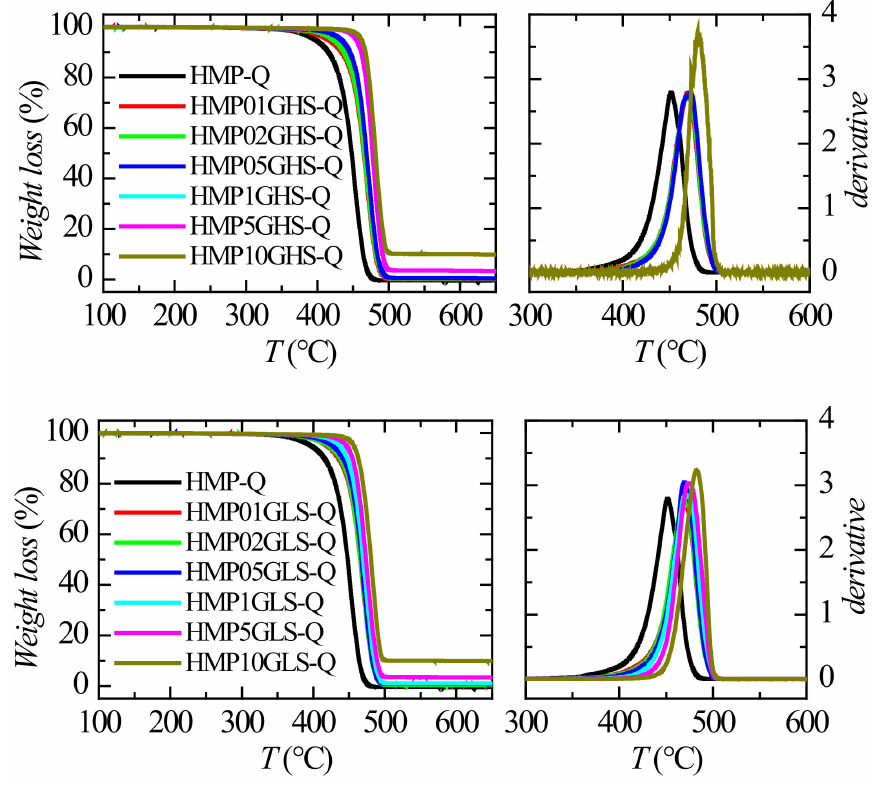
Figure 5. Weight loss curves (left) and their derivatives (right) as a function of temperature for the different nanocomposites with the Q thermal